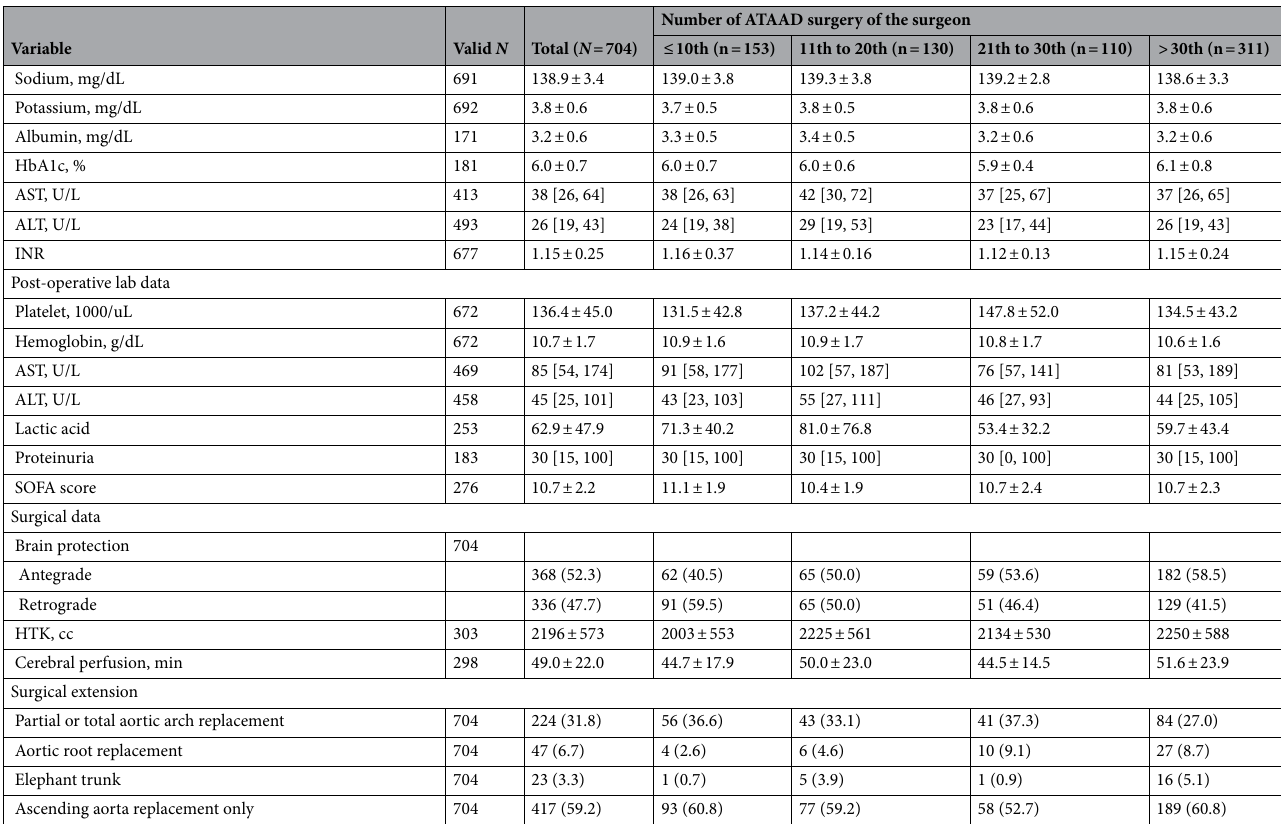
Table 1. Baseline characteristics of the patients according to the cumulative operation volume of the surgeon. ATAAD acute type A aortic dissection, BMI body mass index, IMH intramural hematoma, COPD chronic obstructive pulmonary disease, WBC whole blood cell, BNP B-type natriuretic peptide, BUN blood urea nitrogen, HCO 3 bicarbonate, HbA1c glycated hemoglobin, AST aspartate aminotransferase, ALT alanine aminotransferase, INR international normalized ratio. Data were presented as frequency (percentage) or mean ± standard deviation or median [Quartile 1, Quartile